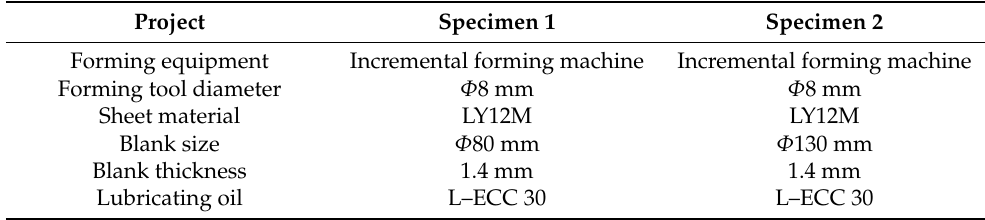
Table 1. Conditions of the forming experiment.